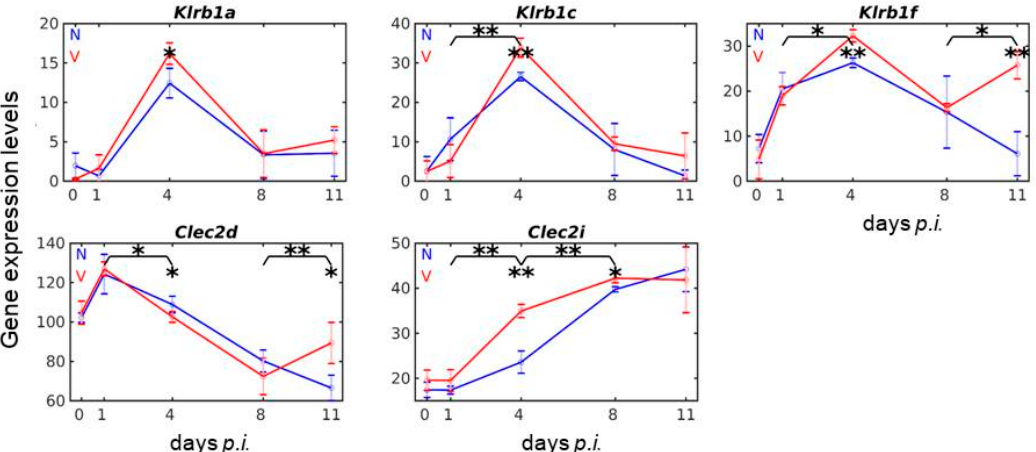
Figure 6. Time series of expressions of Klrb1 and Clec2 genes encoding receptors and ligands involved in MHCI-independent tissue surveillance. RNA was isolated from individual livers prepared from vaccination-protected (V, red) and non-vaccinated (N, blue) mice infected with P. chabaudi blood-stage malaria on days 0, 1, 4, 8, and 11 p.i . Gene expression levels in linear scale are plotted as the means of three microarrays ± SD. The number of “*” marks over interval lines between two sampling points and over sampling points indicate statistical significance between two corresponding intervals and between a given sampling point, respectively, between vaccinated and non-vaccinated mice: * p < 0.05; ** p < 0.01.